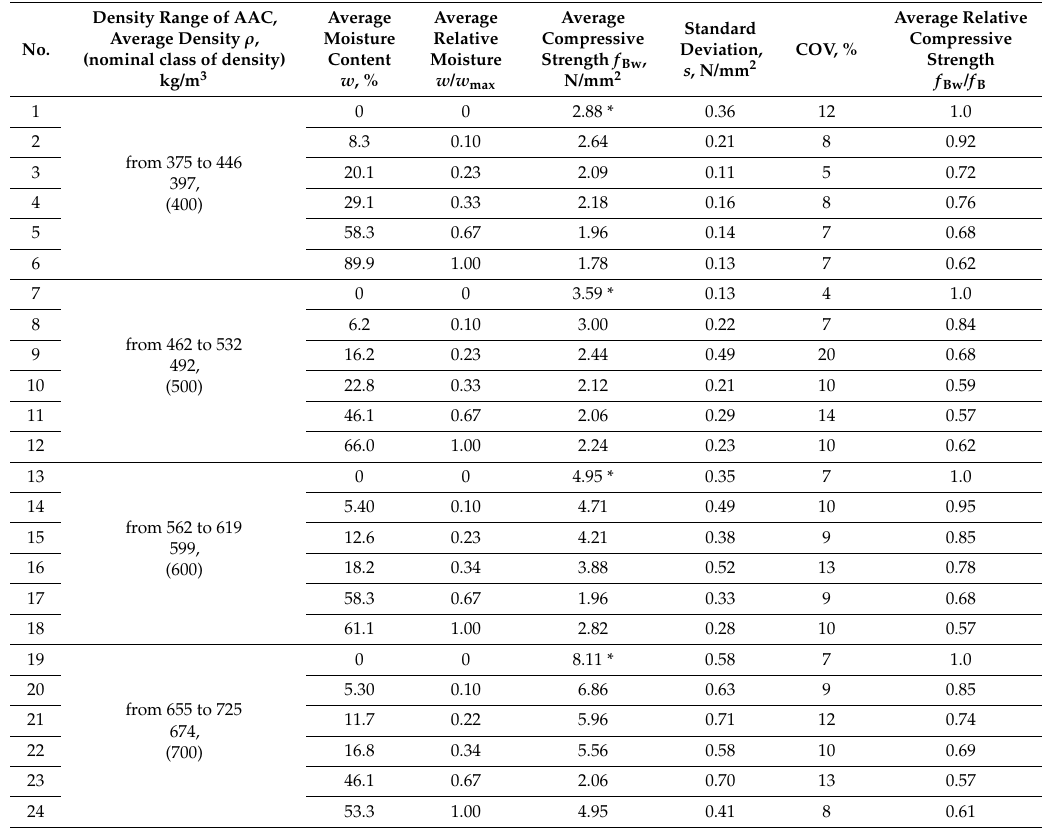
Table 5. Test results for AAC with varying moisture